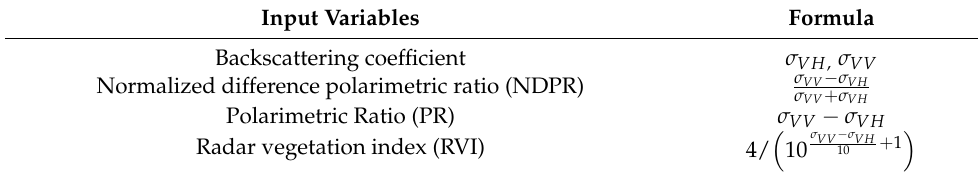
Table 3. Overview of the input variables of the random forest (RF) model used in the modeling of PWN infestation from Sentinel-1